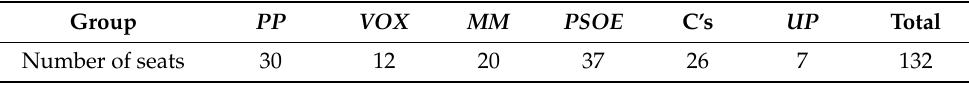
Table 9. Apportionment of seats in the XI Legislature.